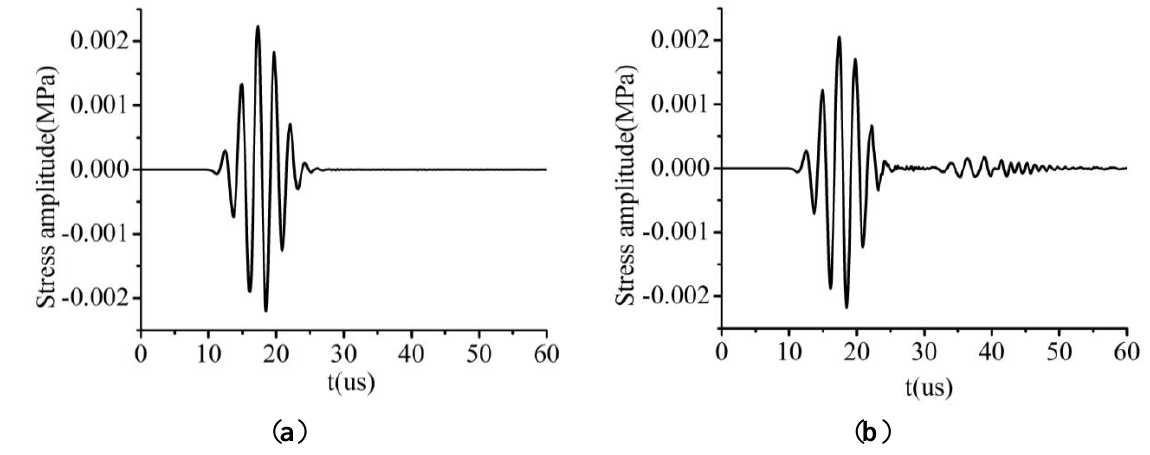
Figure 9. ( a ) Time-domain signal received from an undamaged plate. ( b ) Time-domain signal received from the damaged plate with a micro-crack 6 nm wide and 800 μm long.